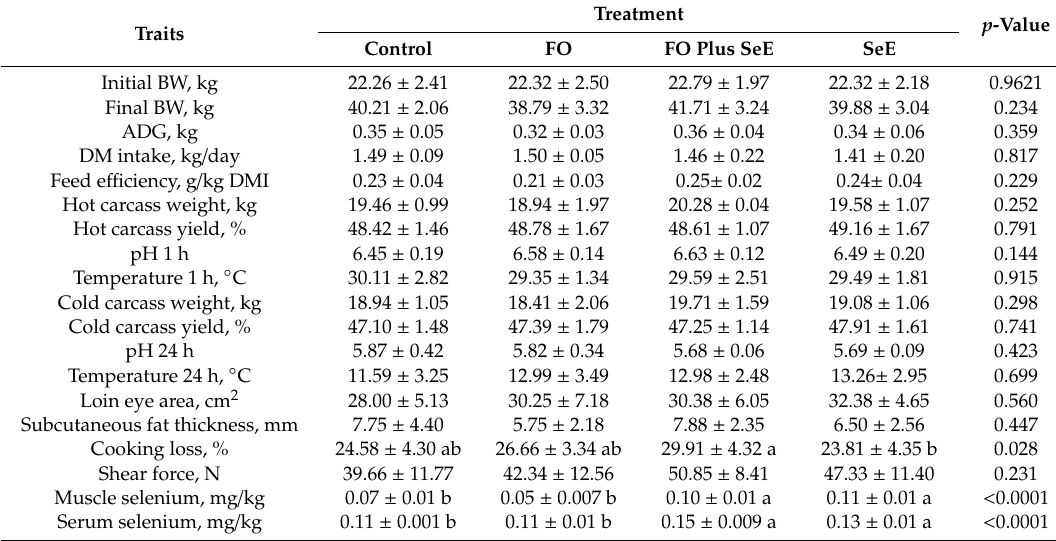
Table 2. Performance, carcass and meat quality traits (means ± s.d.) of Dorper x Santa Ines lambs fed a high-concentrate diet with di ff erent antioxidants.